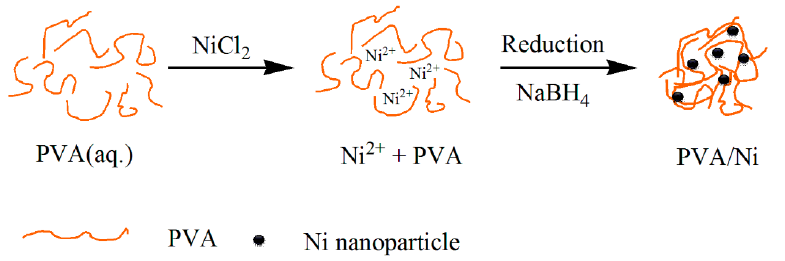
Figure 10. The schematic representation of simultaneous formation of the magnetic gel containing Ni nanoparticles [133].